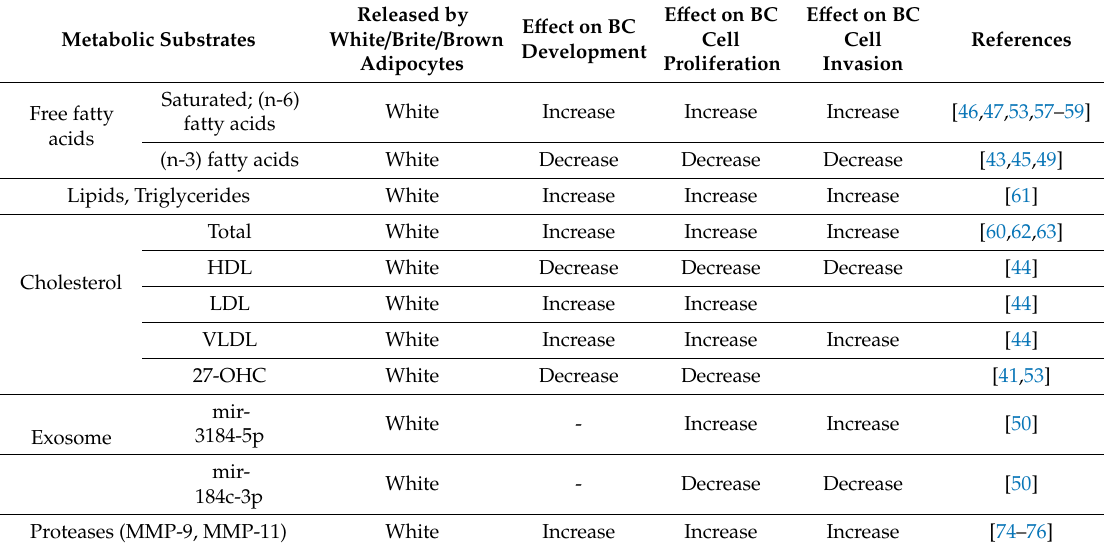
Table 1. Adipocytes regulate breast cancer via their metabolic